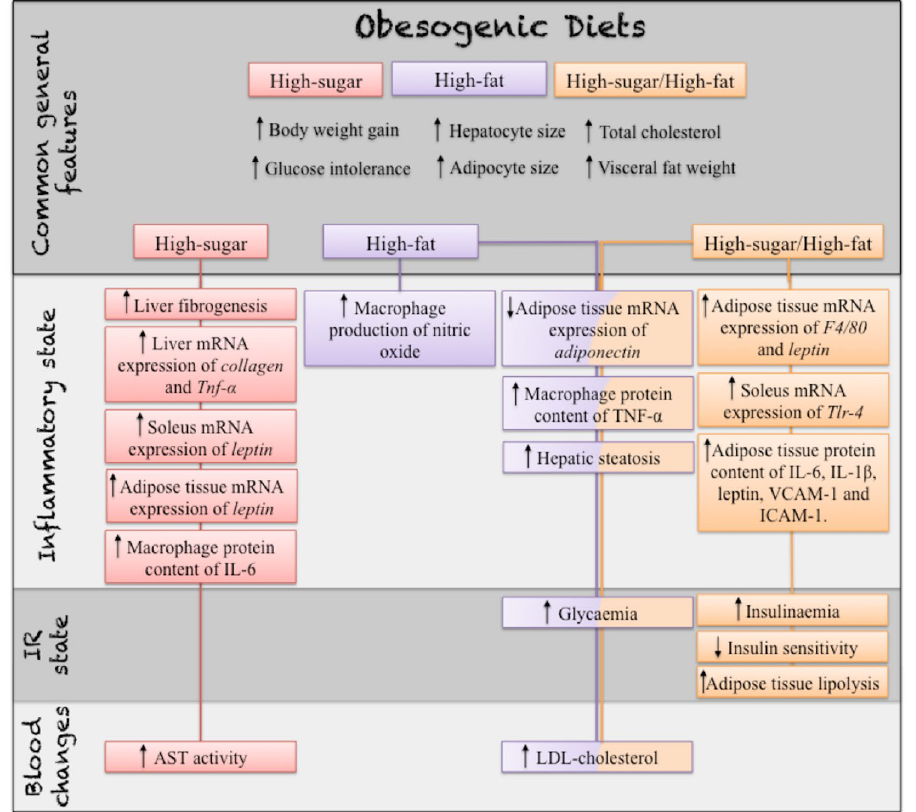
Figure 5. Summary of the effects of the three obesogenic diets, high-sugar (HS), high-fat (HF) and high- sugar/high-fat (HSHF), given to the mice for eight weeks. Up arrows indicate an increase, and down arrows indicate a decrease. The descriptions of the effects descriptions were subdivided into common general features, inflammatory state, insulin resistance (IR) state and changes in blood. AST, aspartate aminotransferase; VCAM, vascular cell adhesion protein 1; ICAM, intercellular cell adhesion molecular 1; IL, interleukin; TNF, tumour necrosis alpha; Tlr-4, toll-like receptor 4; IR, insulin